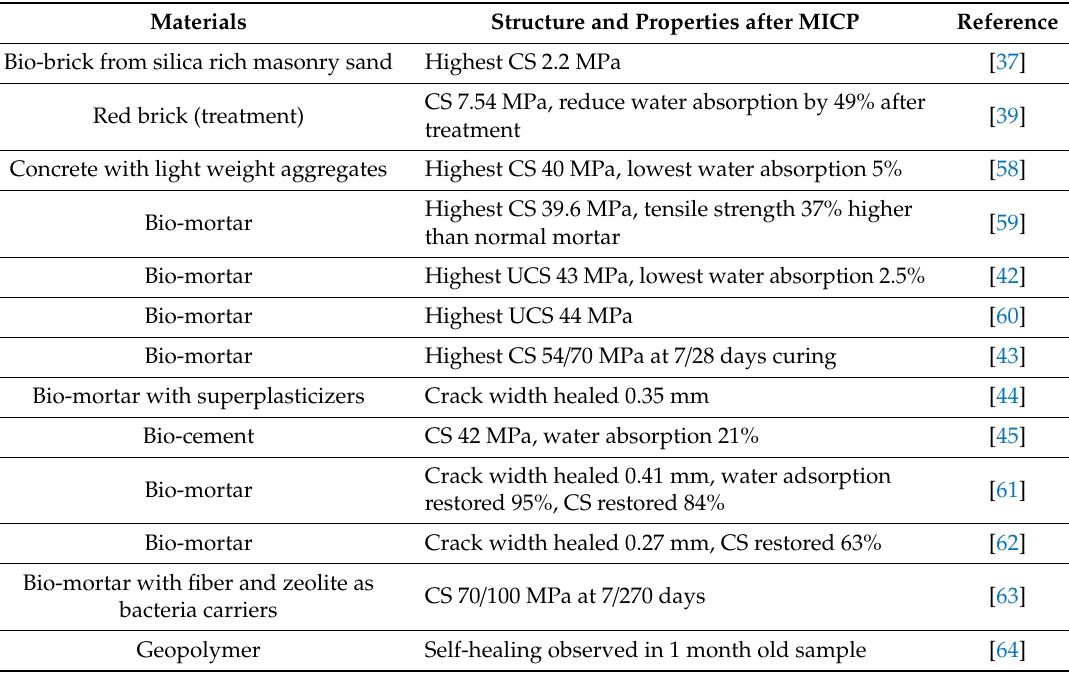
Table 2. Construction materials made by MICP with Sporosarcina